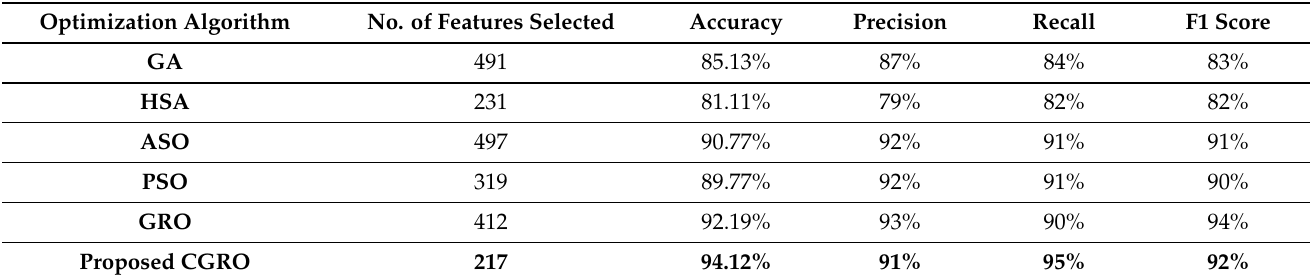
Table 9. Comparative study of different optimization algorithms with proposed CGRO based FS algorithm on Chest X-Ray 3 class dataset. The performance of proposed algorithm has been highlighted in bold text format. Optimization